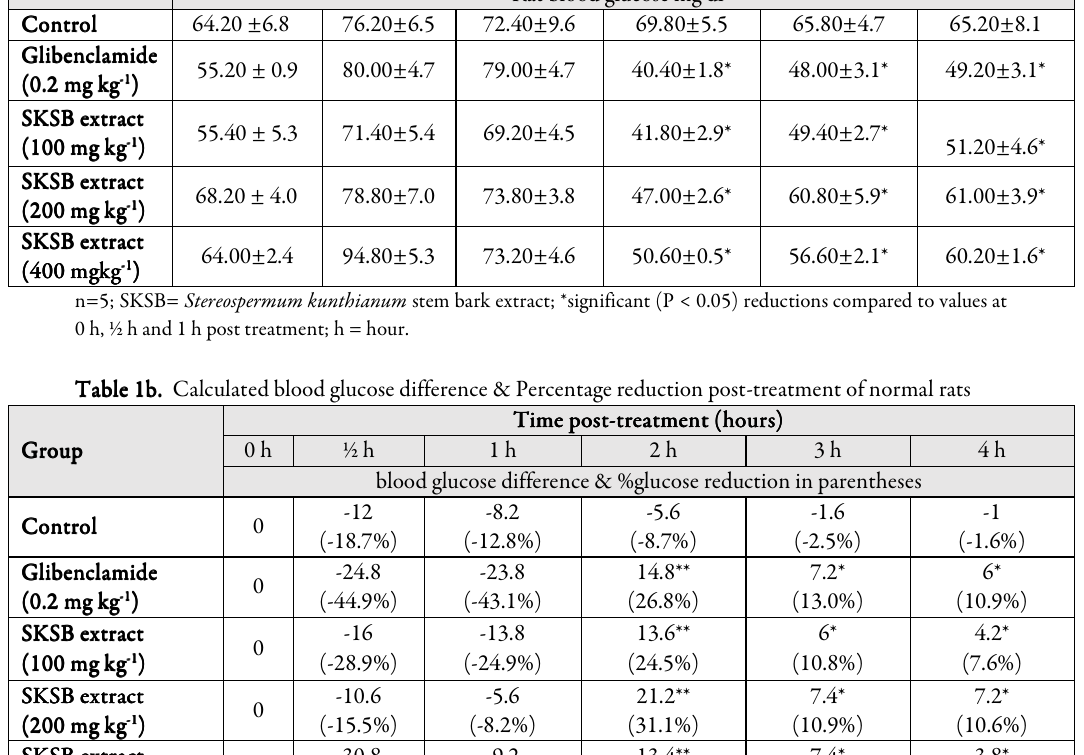
Table 1a. Hypoglycemic activity of SKSB extract in normal rats Group